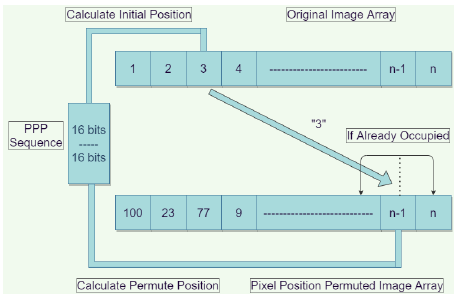
Figure 4. Permutation process for the proposed encryption